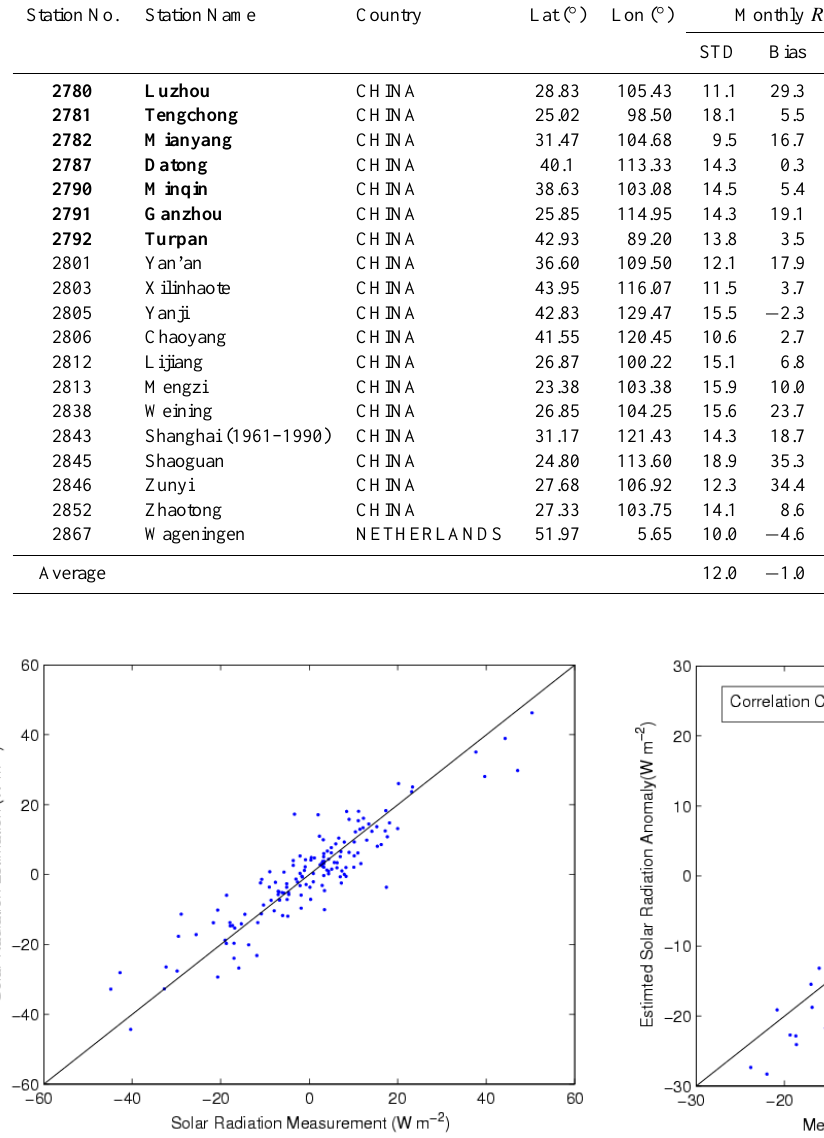
Fig. 3. An example of the comparison between monthly R s anomalies from direct measurements and our prediction from SunDu at GEBA station No. 1193 (Kucharovice, see Table 1). More information on other stations is available in Table 1.